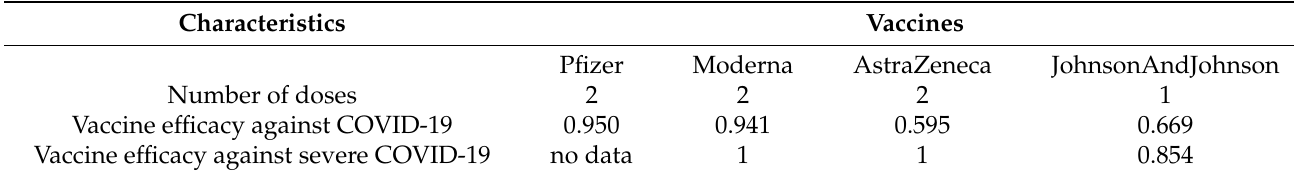
Table 2. Characteristics of vaccines